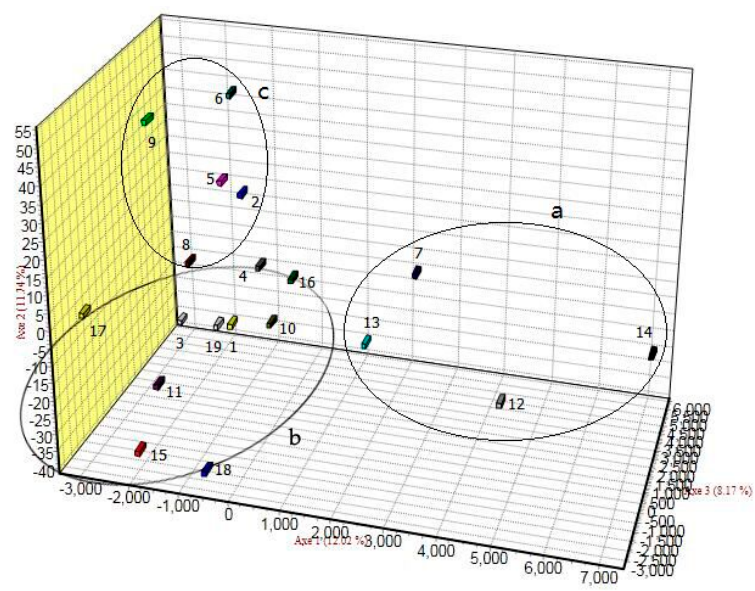
Figure 2. Results of factorial correspondence analysis at the population level based on simple sequence repeat markers. The population codes are as in Table 1.